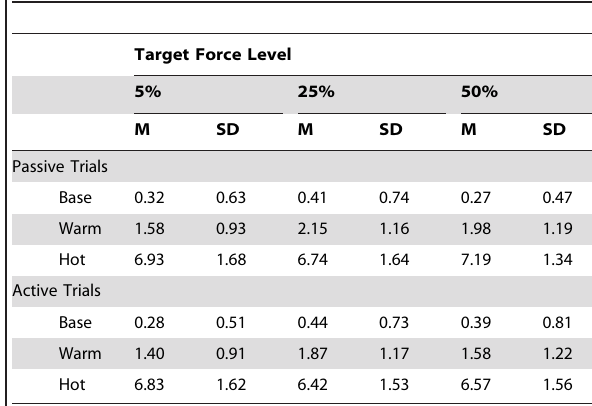
Table 2. Mean rating data for passive trials and active force trials for each temperature and for each target force level.